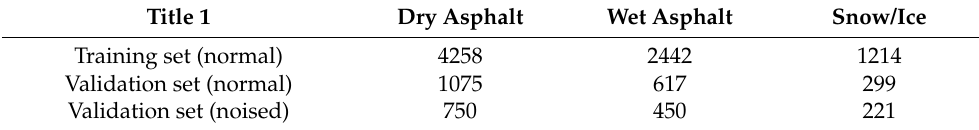
Figure 4. The reliability diagrams of the classification model before and after calibration. ( a ) Relia- bility diagram of the original model; ( b ) Reliability diagram of the calibrated model.